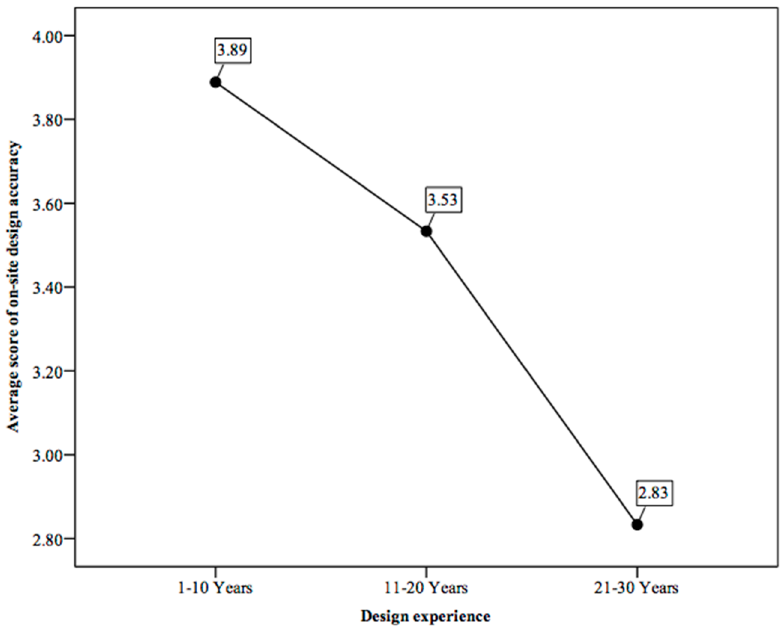
Figure 13. The average scores for on-site design accuracy using MR in different design experience groups.